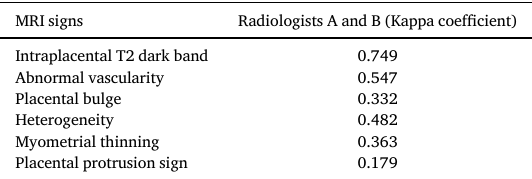
Table 4 Interobserver